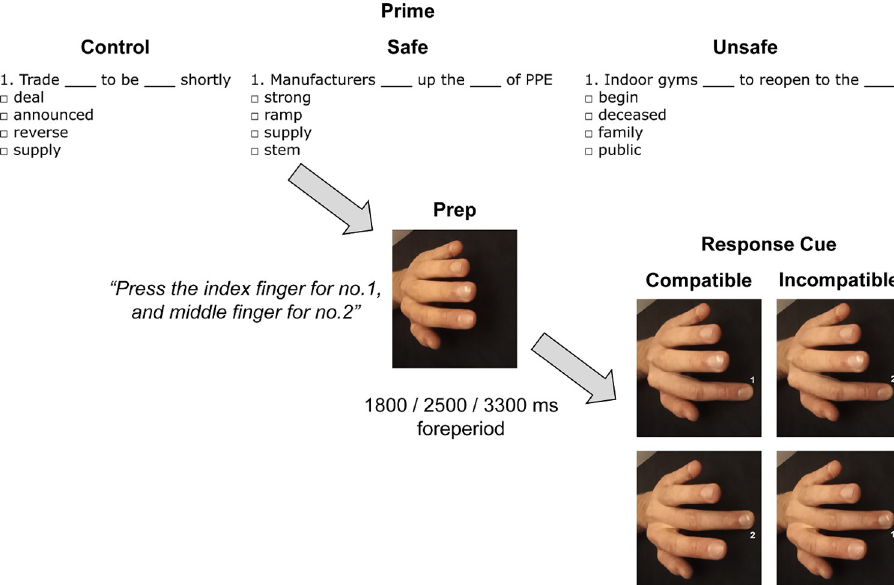
Fig 1. Outline of the tasks and procedure. Participants were first assigned one of the prime conditions (control, safe, unsafe) before attempting the stimulus-response task, where the background hand stimuli were either compatible or incompatible with the cued